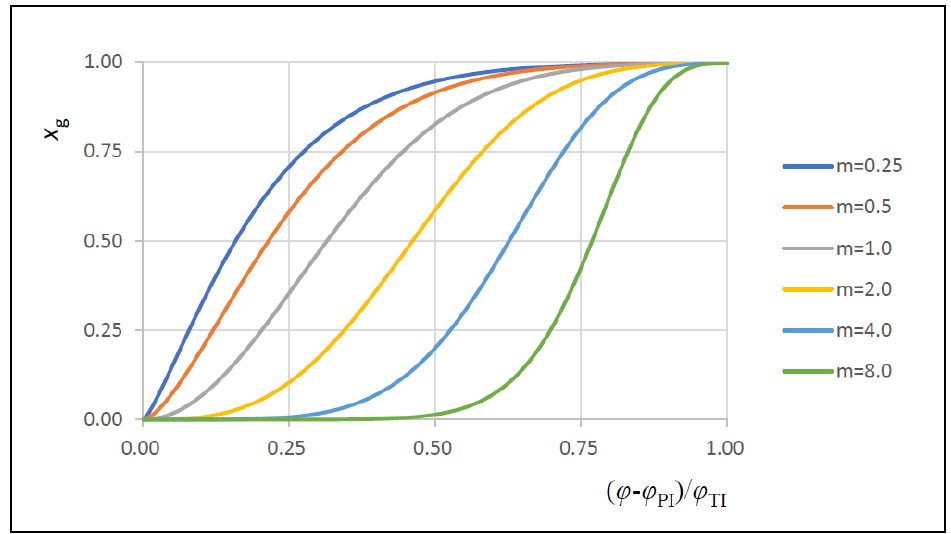
Figure 3. Relative share of burned fuel as a function of crank angle, for different Vibe exponents, m [21,22].